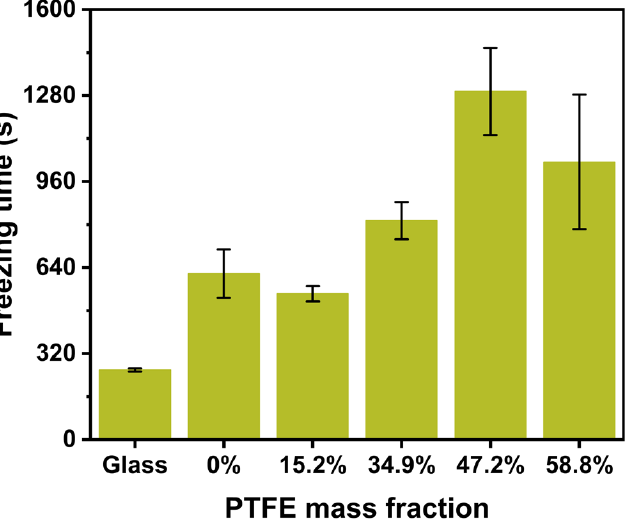
Figure 7. Freezing time of water droplets placed on glass and coatings with different PTFE mass fractions.